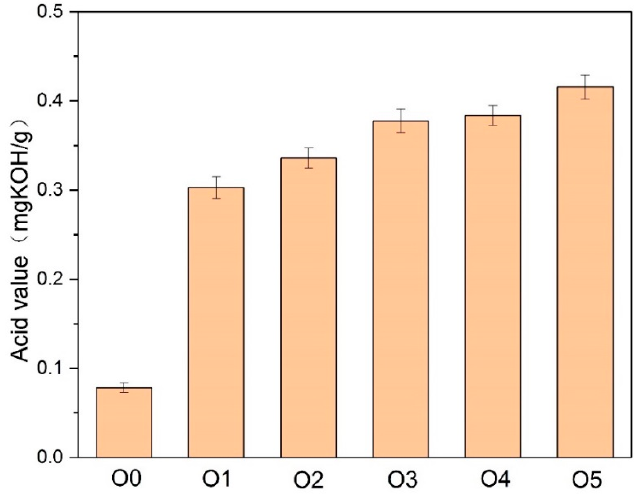
Figure 4. The influence of the different amine compounds in the paper-oil insulation on the acid value of oil after the aging process.